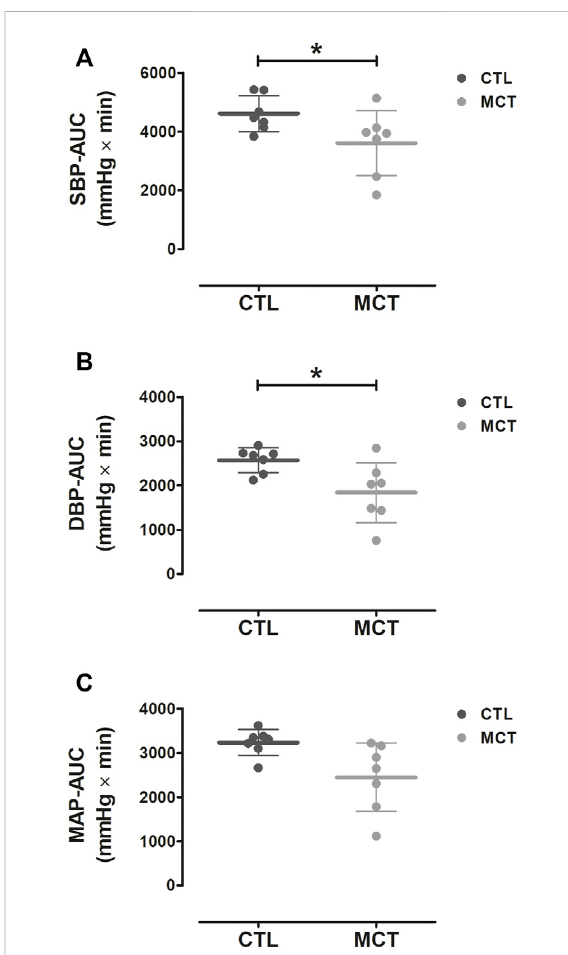
FIGURE 3 Mean ± SD AUCs for SBP (A) , DBP (B) , and MAP (C) during the fi rst 40 min after the experimental trials. AUC, area under the curve; MCT, mixed circuit training; CTL, non-exercise control session; SBP, systolic blood pressure; DBP, diastolic blood pressure; MAP, mean arterial pressure. *, Signi fi cant difference between CTL vs. MCT ( p <